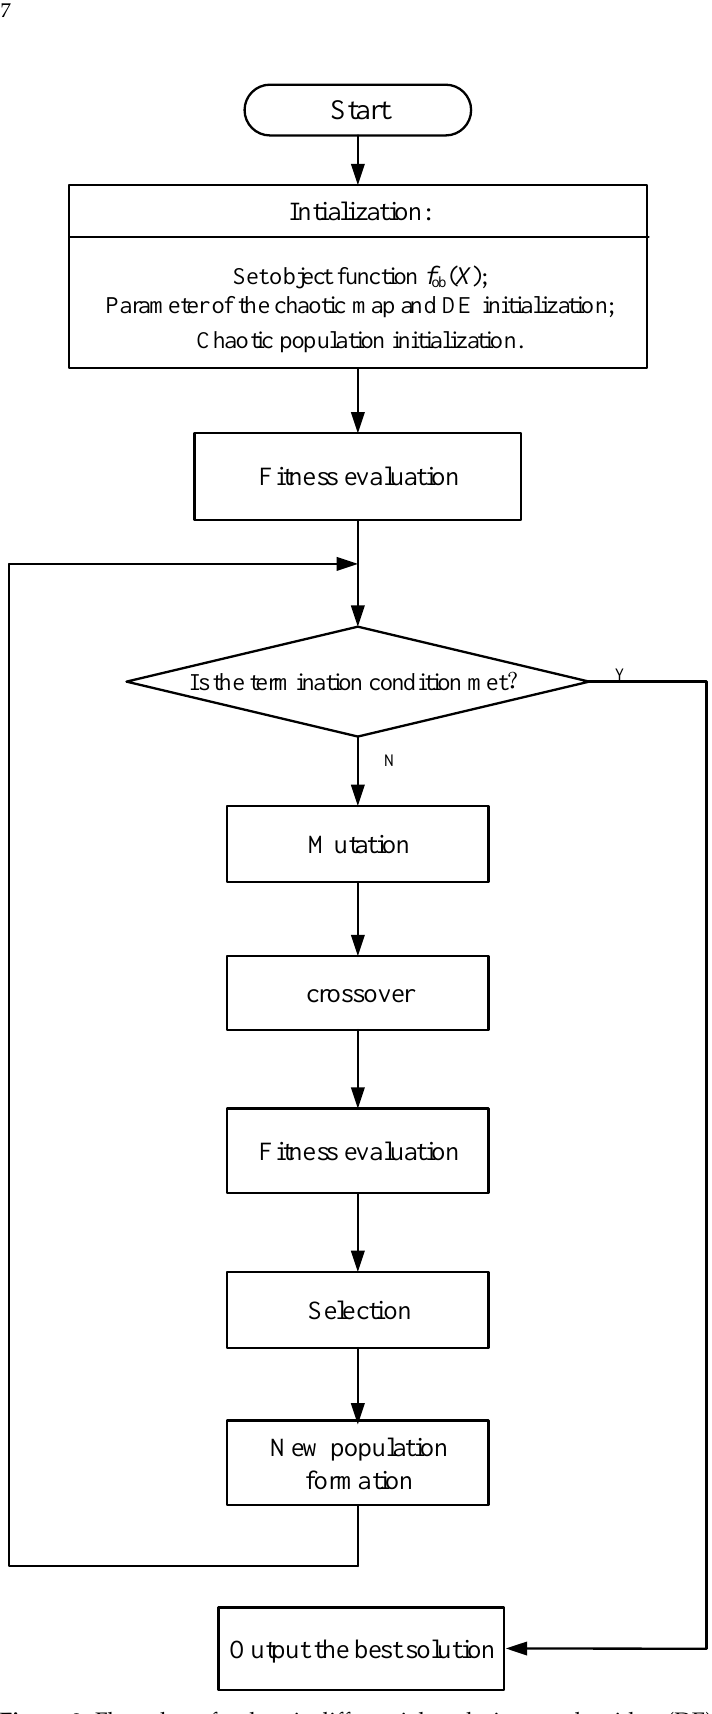
Figure 2. Flow chat of a chaotic differential evolutionary algorithm